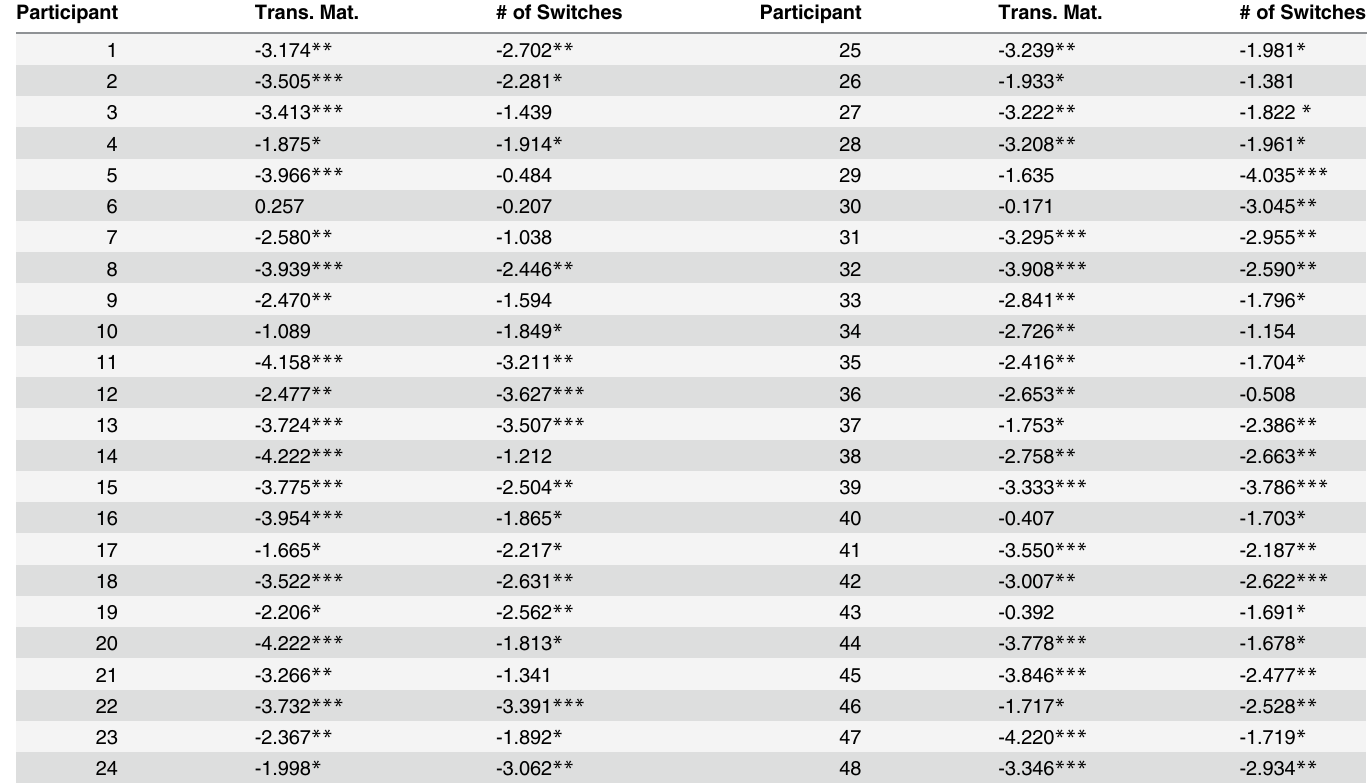
Table 1. Participants with idiosyncratic switching patterns based on transition matrices (Trans. Mat.) and number of perceptual switches (# of Switches) by Wilcoxon's Z values. Participant Trans.